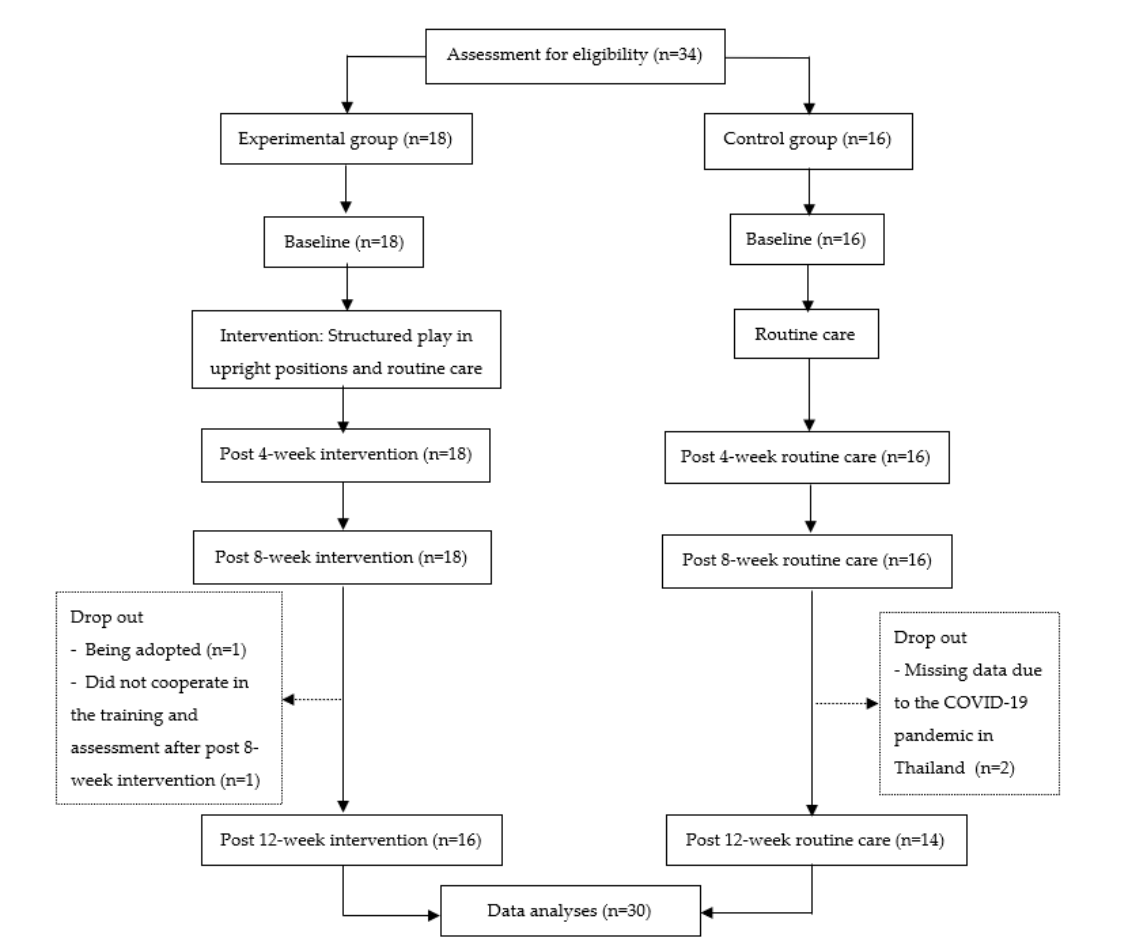
Figure 1. Flowchart of participant enrollment and analysis.